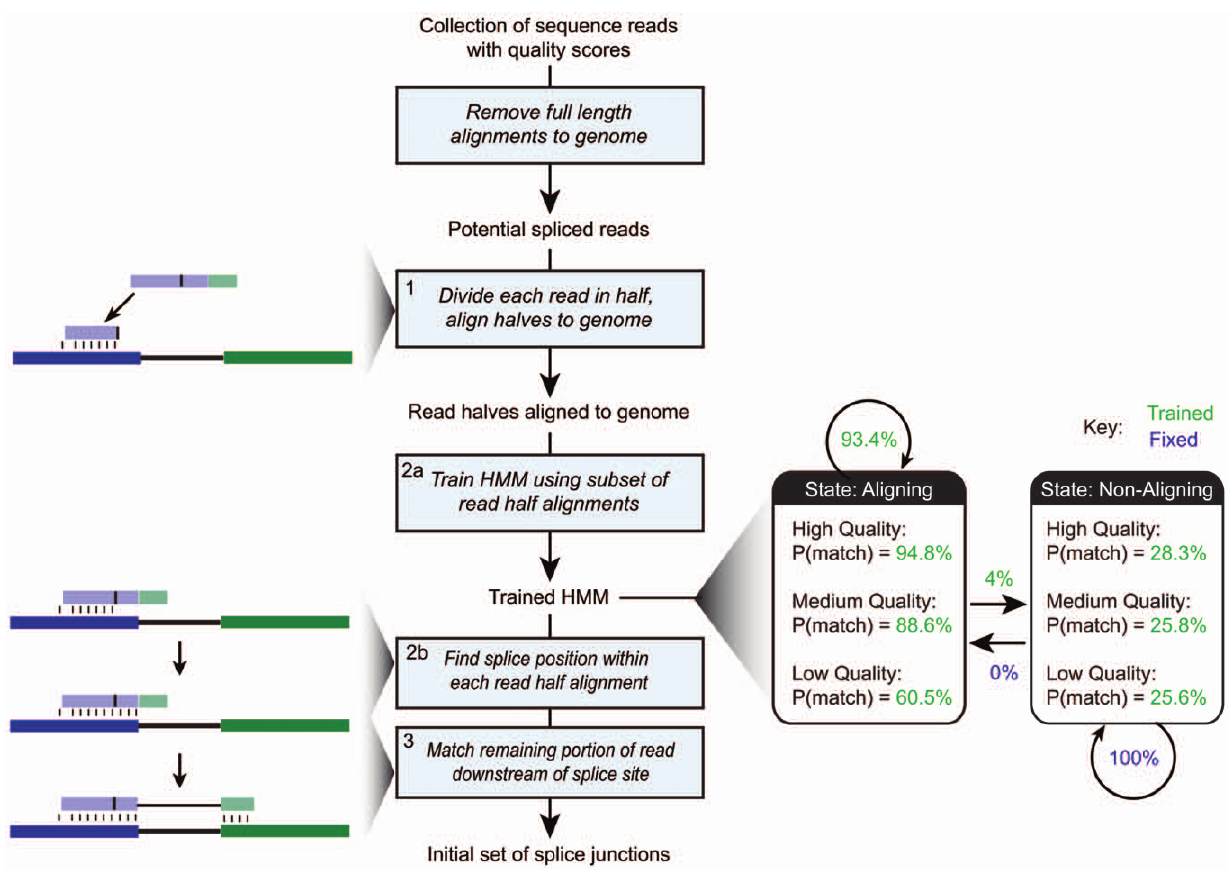
Figure 1. HMMSplicer pipeline. After removing reads that have full-length alignments to the genome, reads are divided in half and aligned to the genome (step 1 as defined in the Materials and Methods). The HMM is trained using a subset of the read-half alignments (step 2a). The HMM bins quality scores into five levels. Although only three levels are shown in this overview for simplification, the values for all five levels can be found in Table 1. The trained HMM is then used to determine the splice position within each read-half alignment (step 2b). The remaining second piece of the read is then matched downstream to find the other intron edge (step 3). The initial set of splice junctions then proceed to rescue (step 4) and filter and collapse (step 5) to generate the final set of splice junctions.